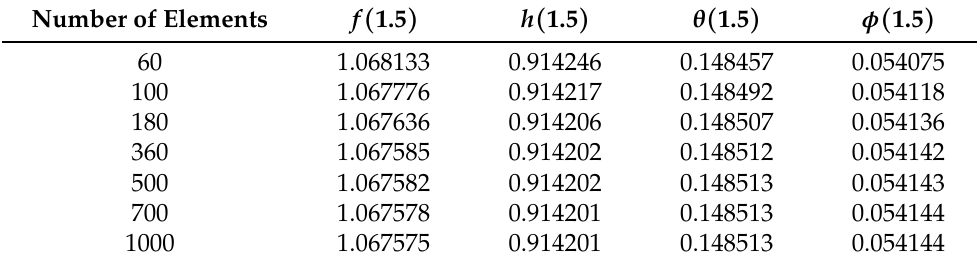
Table 1. Finite element method (FEM) convergence results of f ( ζ ) , p ( ζ ) , θ ( ζ ) , and φ ( ζ ) at the 1.5 of computational domain [0, 12] for different number of elements when Pr = 1, λ s = 0.5, A = Q = We = 0.2, Ha = 0.5, Bi = EE = γ = 1, Nt = Nb = 0.3, ω = 3, (cid:101) = 0.3, Le = 3, Rd = 0.5, β = 0.5, n = 1, f w =